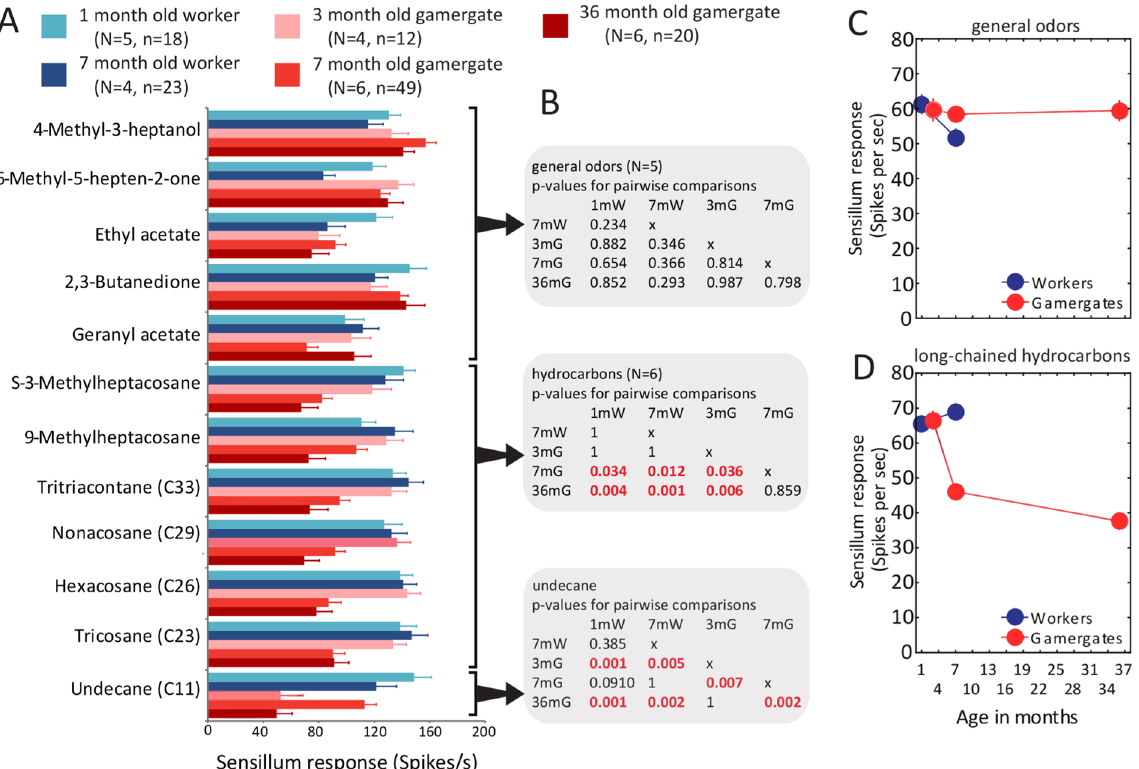
Figure 4. Worker group specific sensillum responsiveness. ( A ) Sensillum responses of non-reproductive workers and gamergates of defined age to a panel of twelve odorants with mean and SEM. (N: number of individuals, n: number of sensilla). ( B ) Differences in the levels of s. basiconica responsiveness to different groups of compounds. Significant differences in the posthoc comparisons are highlighted (Linear mixed model with Fisher’s LSD and Holm-Bonferroni correction) (1 and 7 month non-reproductive workers: 1 mW and 7 mW; 3, 7, and 36 month gamergate: 3 mG, 7 mG, and 36 mG), ( C ) Pooled sensillum responses (mean ±